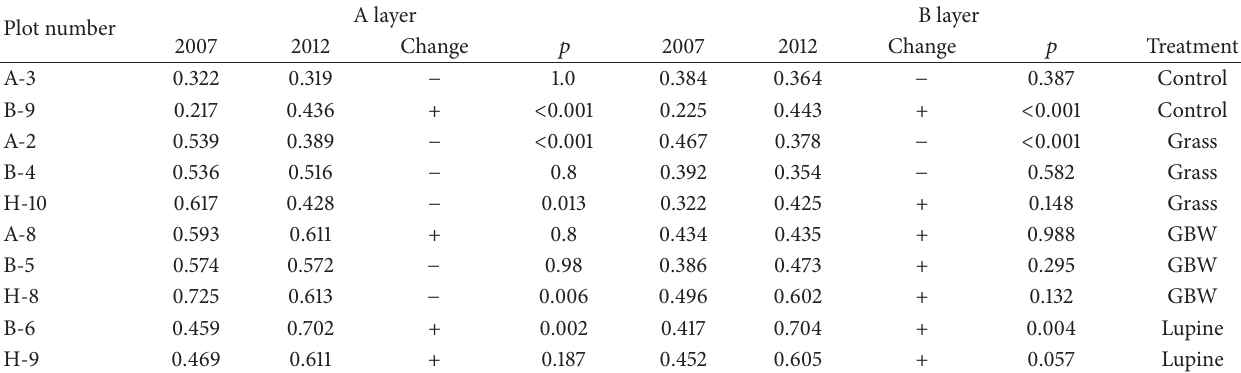
Table 2: Results for soil carbon analysis from this study compared with results for individual plots sampled in 2007 (study by Arnalds et al. 2013 [20]). The significance (probability 𝑝 ) of the difference is evaluated by one-way